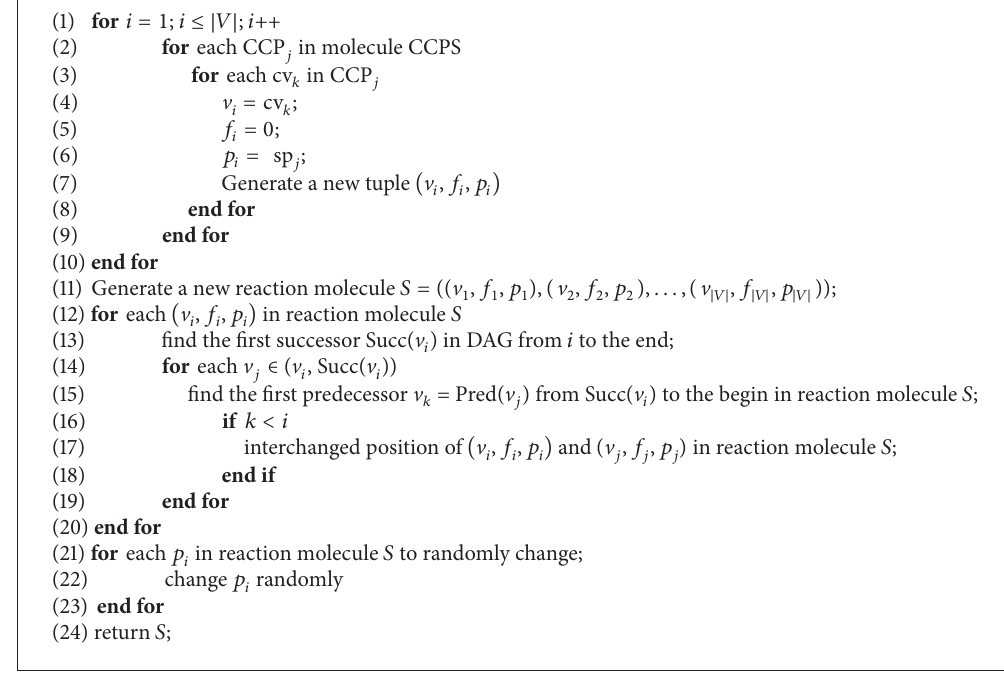
Algorithm 4: ConvertMole(CCPS) converting a CCPS to an 𝑆 .